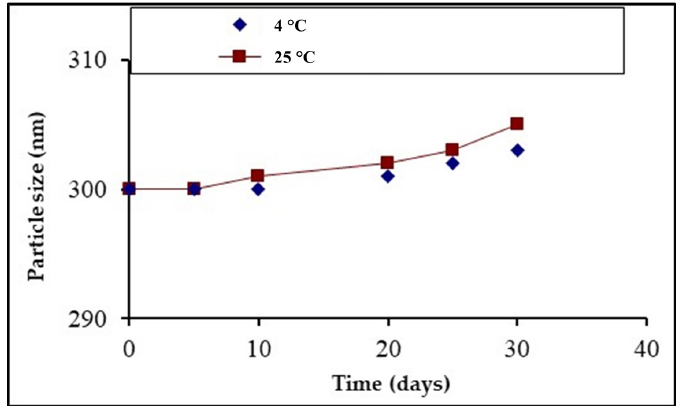
Figure 4. Comparative stability studies of LX NCs at different temperatures.